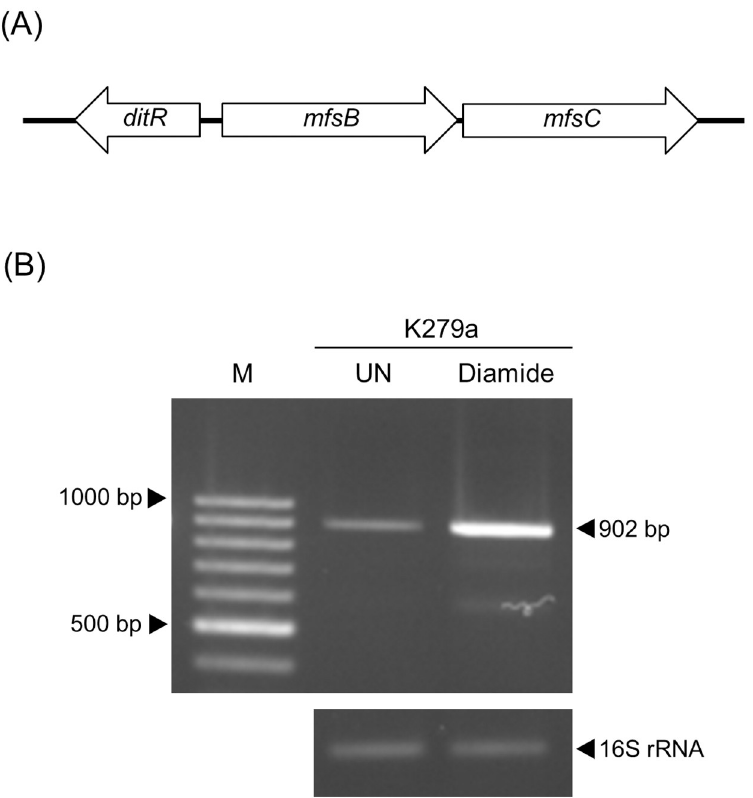
Fig 4. Gene organization and operon structure analysis of mfsB and mfsC . (A) Gene organization of ditR , mfsB and mfsC in S . maltophilia K279a. (B) Operon structure analysis of mfsB and mfsC was performed using RT-PCR. Total RNA were extracted from S . maltophilia K279a cultures grown under uninduced condition (UN) and induction with 500 μ M diamide. After reverse transcription, cDNA was used as templates for PCR amplification using primers BT4612 and BT4617 flanking intergenic region of mfsB and mfsC with an expected size for the PCR product of 902 bp. The 16S ribosomal RNA was used as a loading control. M represents 100-bp DNA